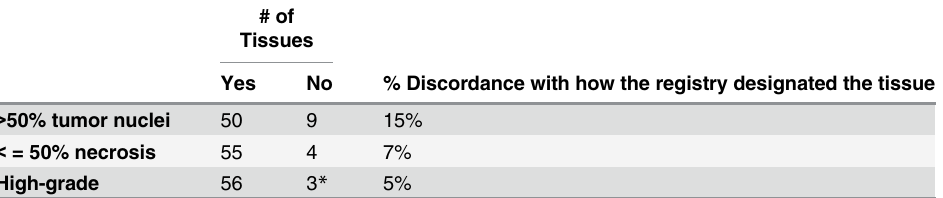
Table 2. Pathology review results of FFPE tissues for serous ovarian adenocarcinoma received at the NCI lab. # of Tissues Yes No % Discordance with how the registry designated the tissue > 50% tumor nuclei 50